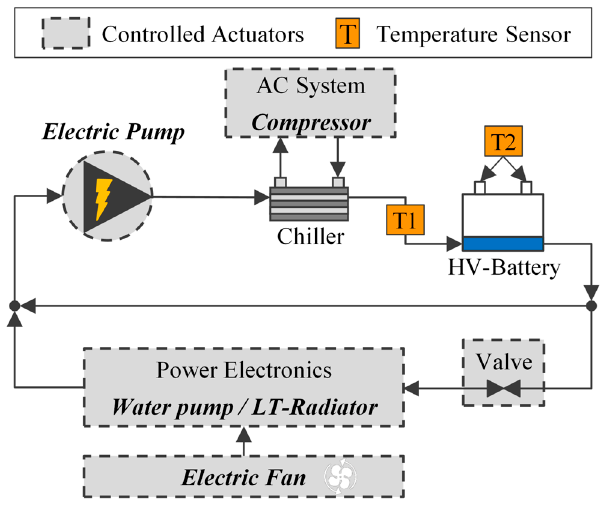
Figure A3. Schematic layout of battery and power electronics low-temperature cooling circuit including controlled actuators (Degas bottle is not included due to simplification).